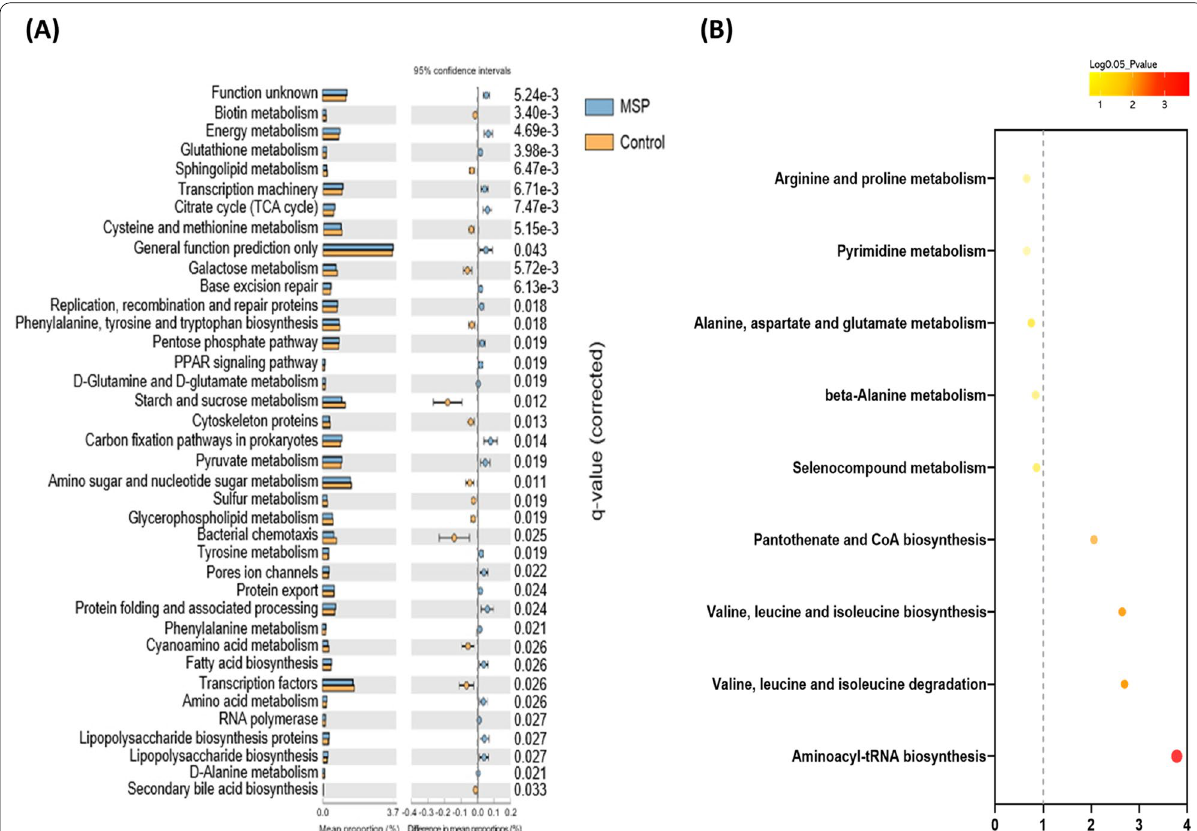
Fig. 6 Metabolic pathway enrichment analysis was performed on differential metabolites. A KEGG pathways predicted in the fecal microbiota of the control and MSP groups using PICRUSt. Statistical analysis was carried out using STAMP software. B Differential metabolic pathways depicted up-regulated or down re-regulated metabolites involved in each metabolic pathway. p- value < 0.05 was considered statistically